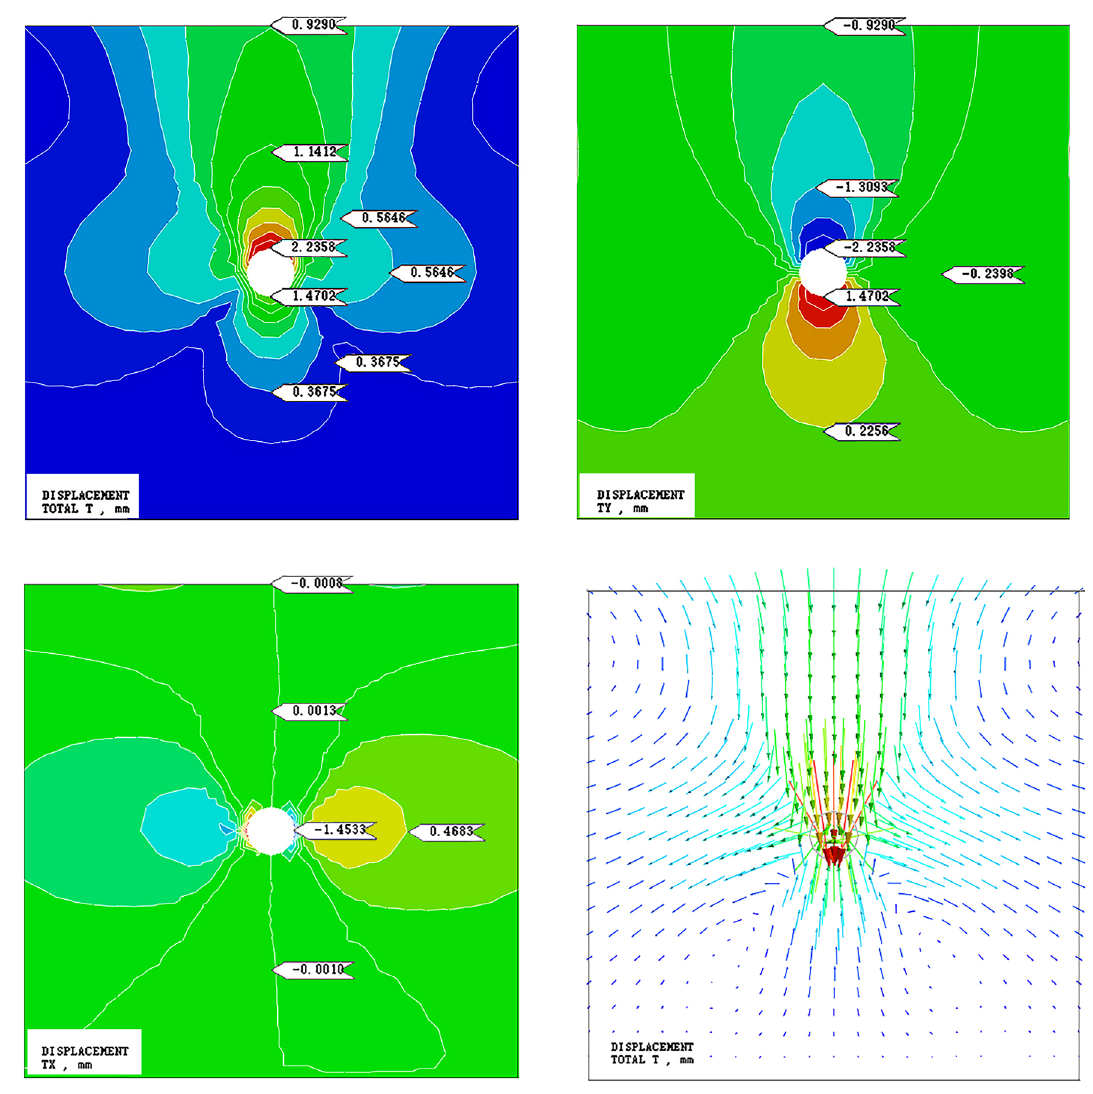
Fig. 3 Displacement field after the hole was